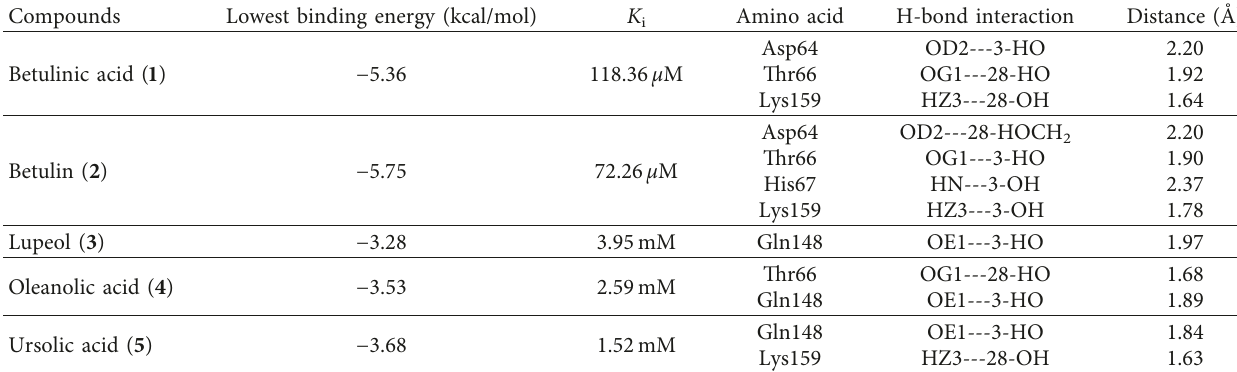
Figure 2: Molecular docking of the isolated compounds with HIV-1 IN. The ribbon model shows the backbone of the HIV-1 IN catalytic domain with all interacting amino acid residues shown as stick models and colored by heteroatoms. H-bond interactions are shown as red dashed lines and represent bond length in angstroms (˚A). Mg 2+ ions are shown as green balls. (a) Betulinic acid ( 1 ), (b) betulin ( 2 ), (c) lupeol ( 3 ), (d) oleanolic acid ( 4 ), and (e) ursolic acid ( 5 ). Table 4: Molecular docking results of pure compounds from B. alnoides